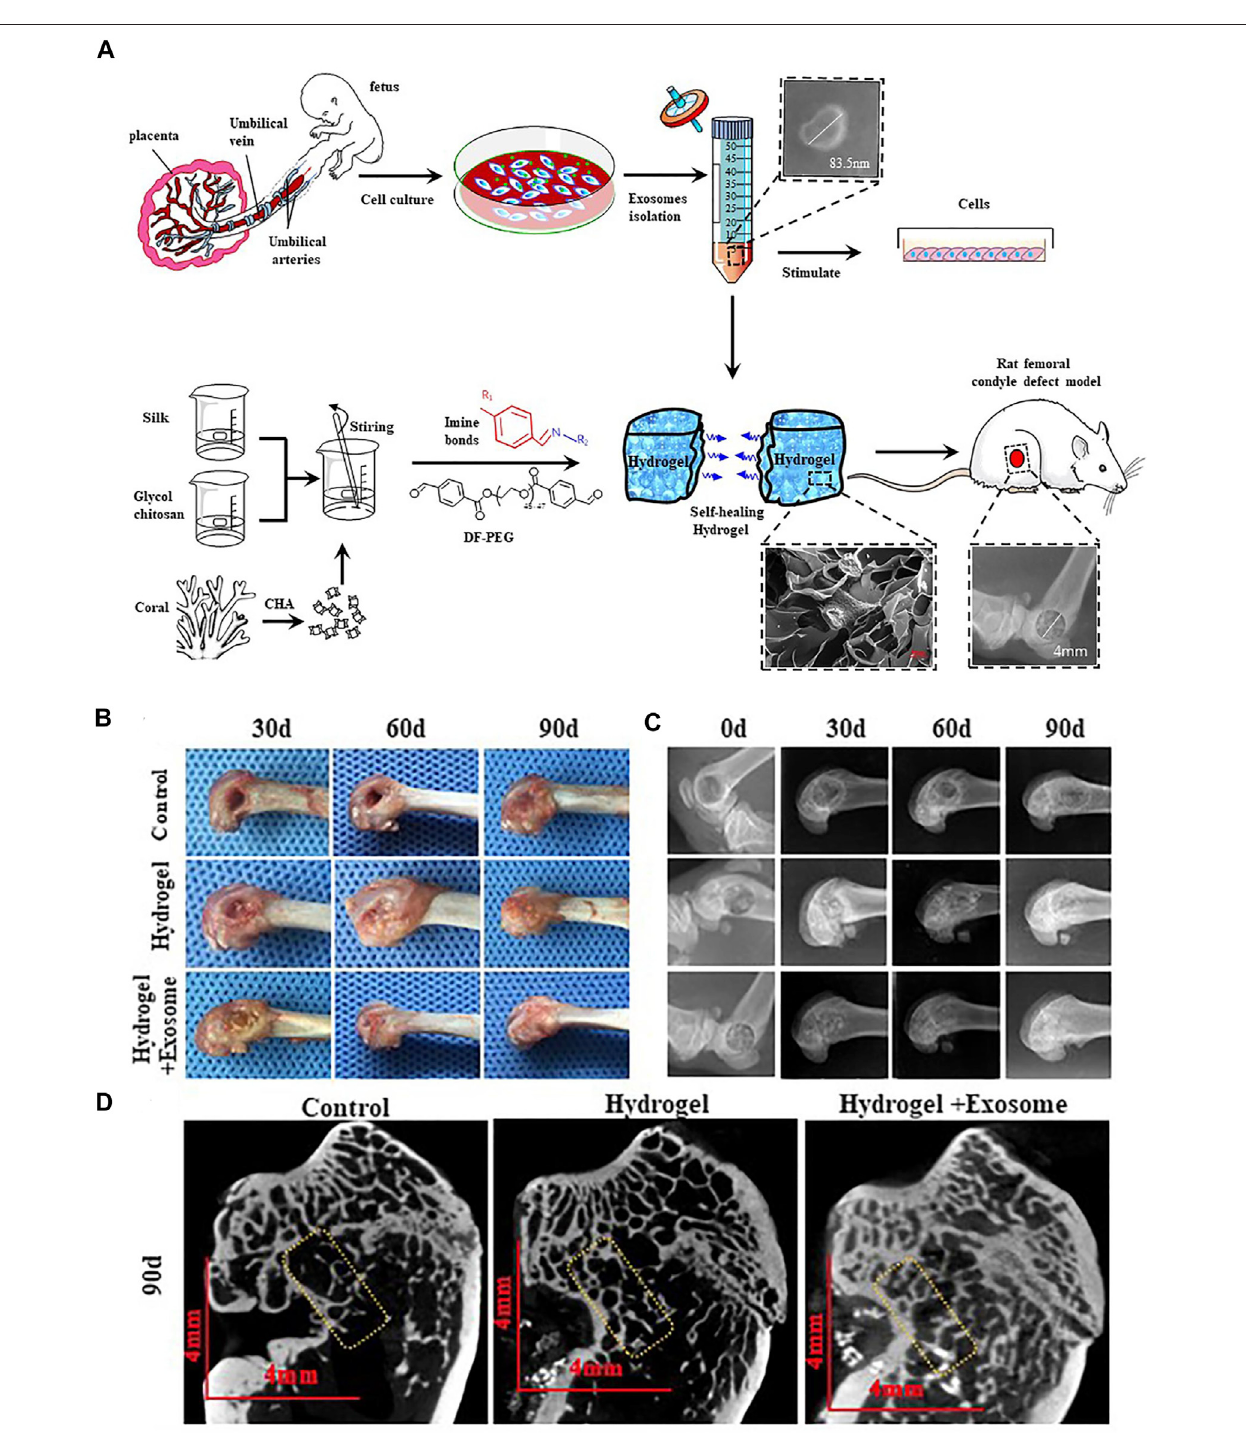
FIGURE 8 | HucMSC-derived exosomes combined with CHA/SF/GCS/DF-PEG hydrogel for the treatment of femoral condyle defects in rats. (A) The separation and identi fi cation of HucMSC-derived exosomes and the preparation of CHA/SF/GCS/DF-PEG hydrogel are used for testing on SD rats with induced femoral condyle defects. (B) 0, 30 and 90 days after implantation of CHA/SF/GCS/DF-PEG hydrogel or CHA/SF/GCS/DF-PEG hydrogel combined with hucMSC-derived exosomes, gross observation (C) X-ray (D) Micro-CT imaging results (Wang et al., 2020). Copyright 2020, Frontiers in Bioengineering and Biotechnology.